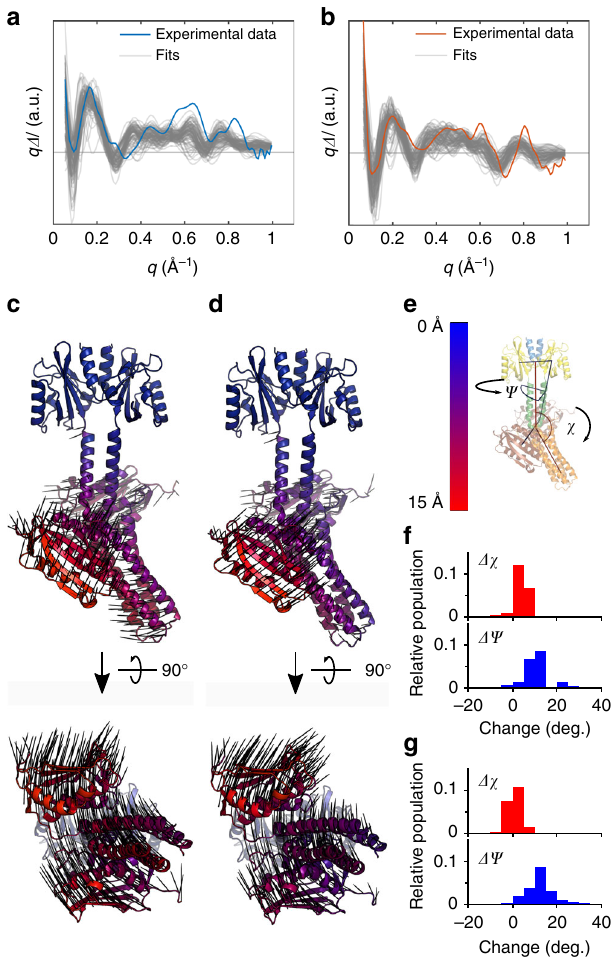
Fig. 4 Structural modeling of X-ray scattering data. a and b Theoretical difference scattering of the best- fi tting pairs and experimental difference scattering for YF1 int. ( a ) and YF1 fi n. ( b ). c and d Schematic representations showing the amplitude of motion relative to the dark-adapted state for YF1 int. ( c ) and for YF1 fi n. ( d ). Movements within the LOV domain are a few Ångströms at most, which makes it appear almost rigid in the context of full-length YF1. e A cartoon depicting the angle ( χ ) and dihedral angle ( ψ ). The arrow tips indicate the direction of positive rotation around χ and ψ (see main text for more precise de fi nition). f and g The distribution of changes in χ and ψ for YF1 int. ( f ) and for YF1 fi n. ( g )